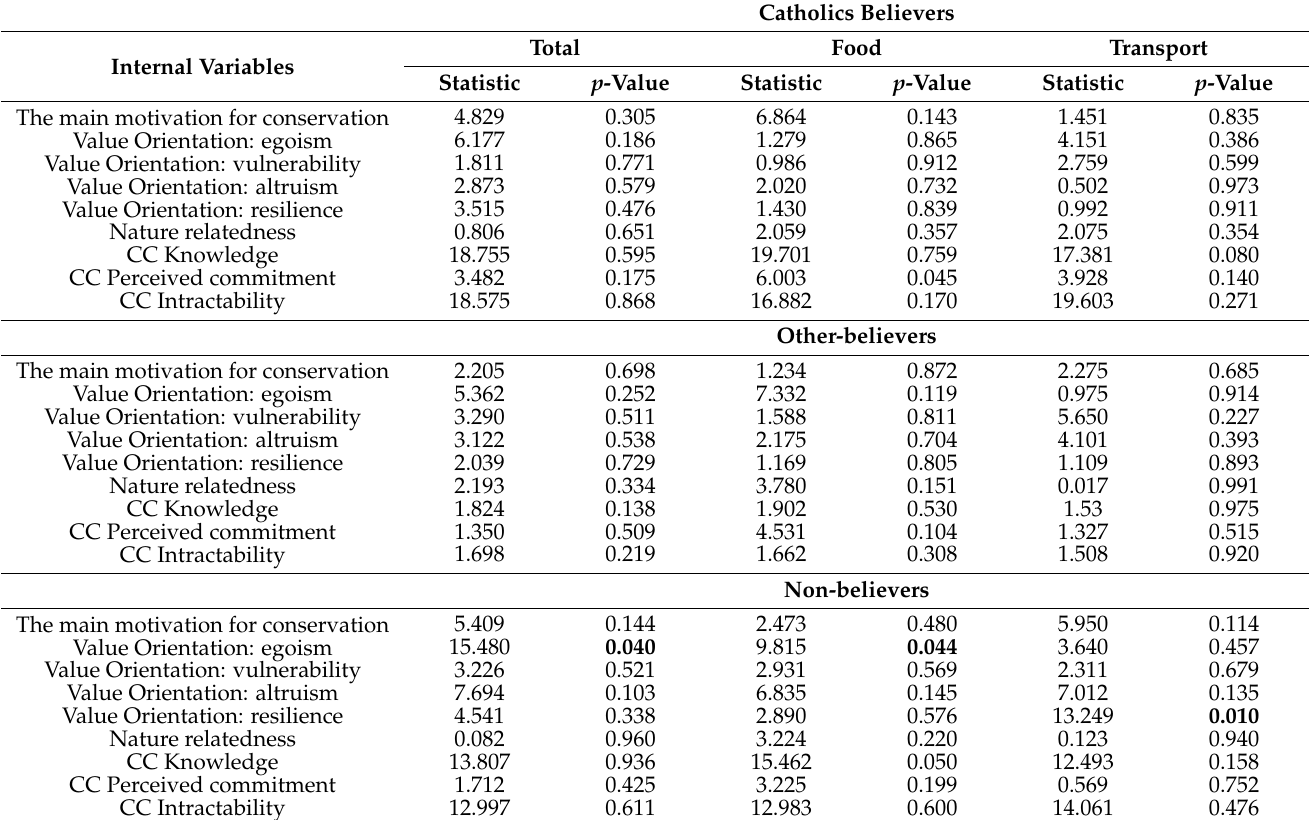
Table 6. Differences in personal CF across internal factors for each religious